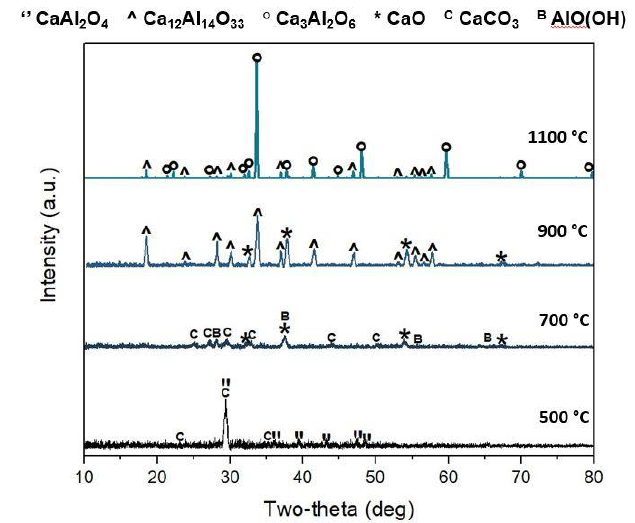
Figure 3. CA-11 diffraction patterns after 2 h calcination under static air at 500 °C, 700 °C, 900 °C and 1100 °C. (JCPDS reference cards: CaAl 2 O 4 : 01-0888; Ca 12 Al 14 O 33 : 09-0413; Ca 3 Al 2 O 6 : 38-1429; CaO: 70-4068; CaCO 3 : 83-1762/19-3758; AlO(OH): 78-4581).